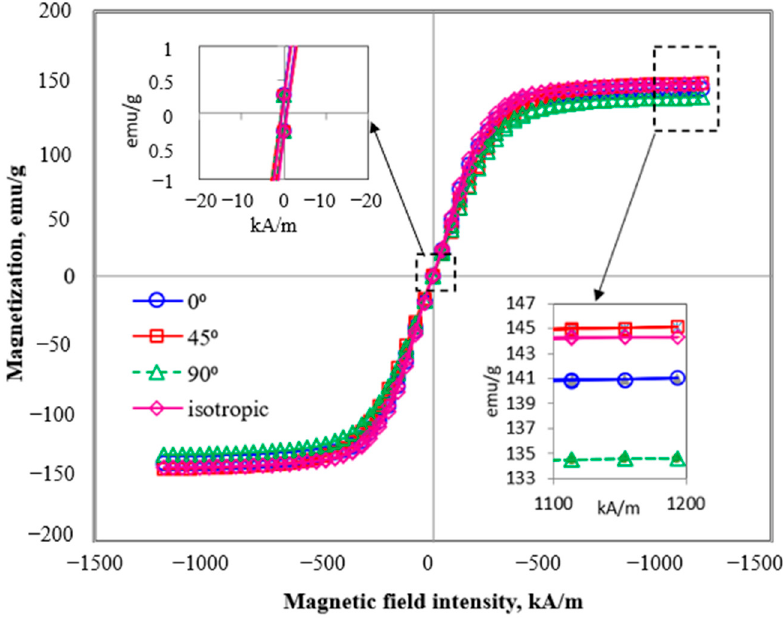
Figure 6. Hysteresis loops of MRE samples at 0 ◦ , 45 ◦ , and 90 ◦ orientations of mold, and isotropic